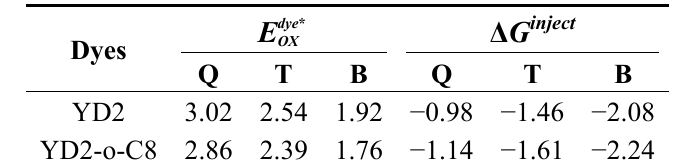
Table 4. The calculated excited states oxidized potential ( E dye * change for electron injection ( Δ G inject , in eV) of Q, T, and B absorption bands for YD2 and YD2-o-C8